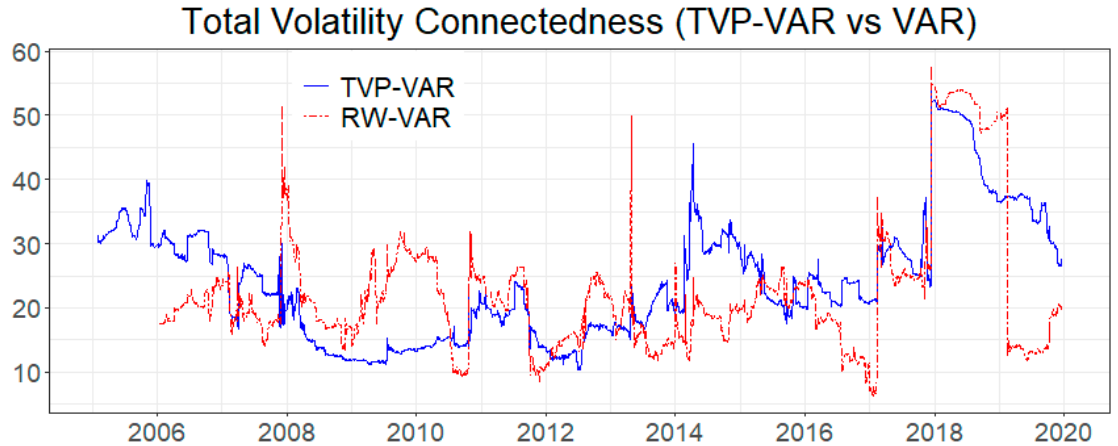
Figure 7. Dynamic total volatility connectedness (TVP-VAR vs. VAR). Note: the horizontal axis is the timeline; the vertical